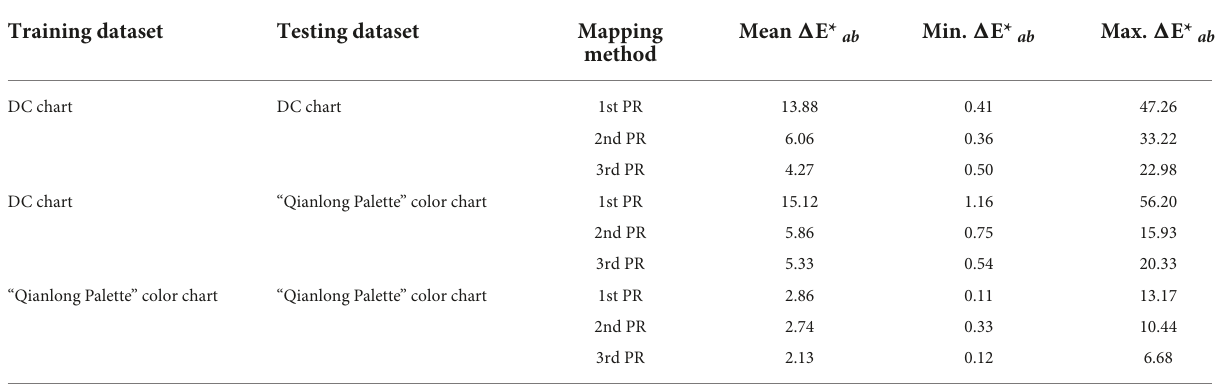
TABLE 1 The camera color characterization